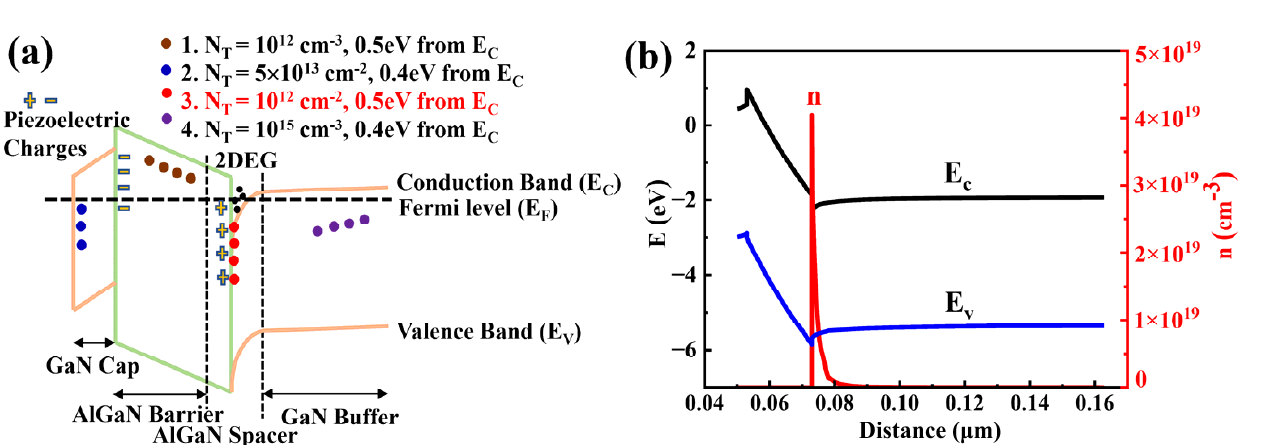
Figure 5. ( a ) Output characteristics of the asymmetrical T ‐ gate AlGaN/GaN HEMT on a silicon carbide substrate with a gate length of 0.25 μ m before stress and ( b ) transfer characteristics before stress [14].